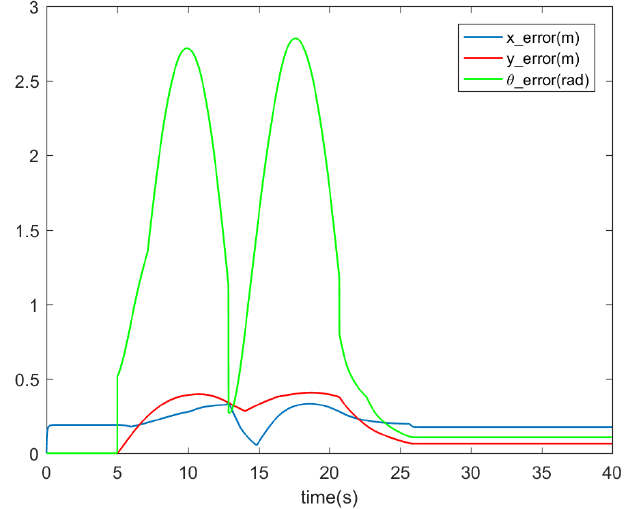
Figure 10. The formation tracking errors for robots in formation with